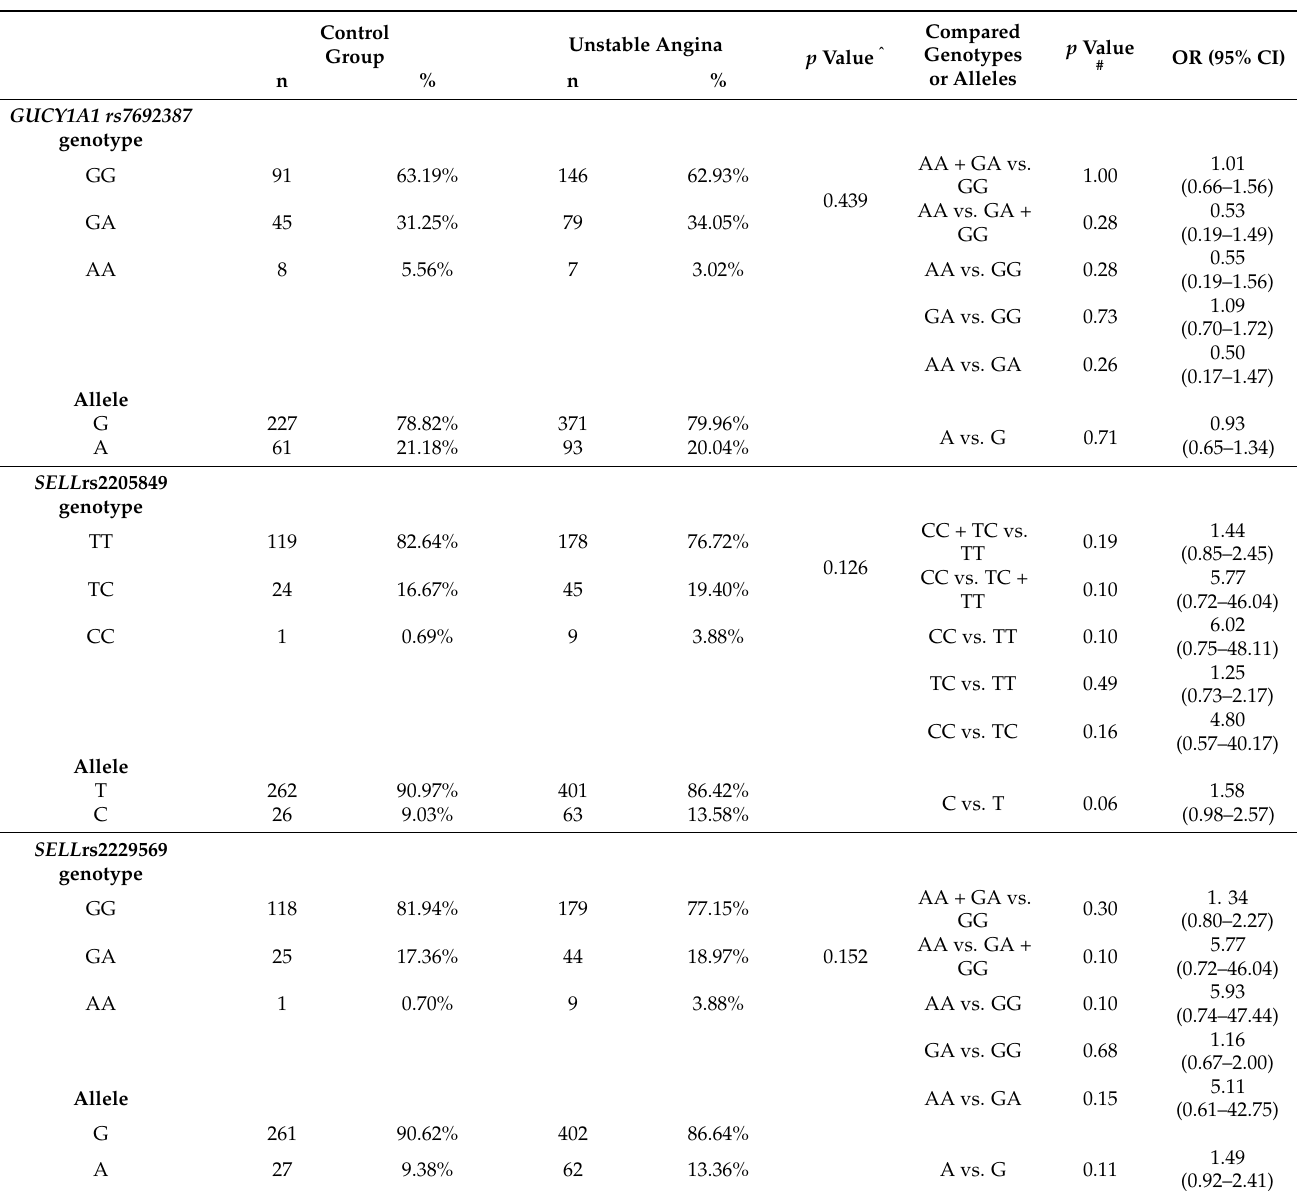
Table 2. Distribution of GUCY1A1 rs7692387, SELL rs2205849 and rs2229569 genotypes and alleles in UA patients and